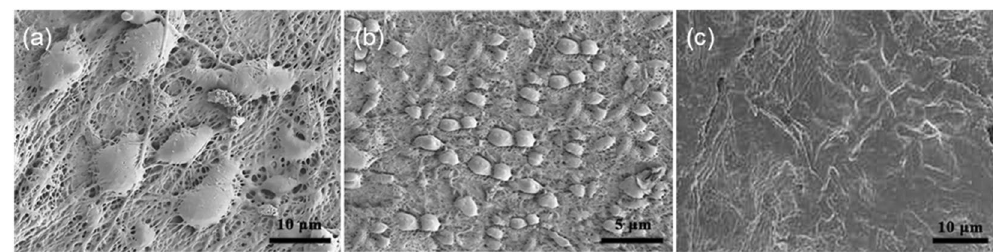
Fig. 10 Representative scanning electron micrographs of HUVECs on bioarti fi cial blood vessels: a Day 2. b Day 4. c Day 9